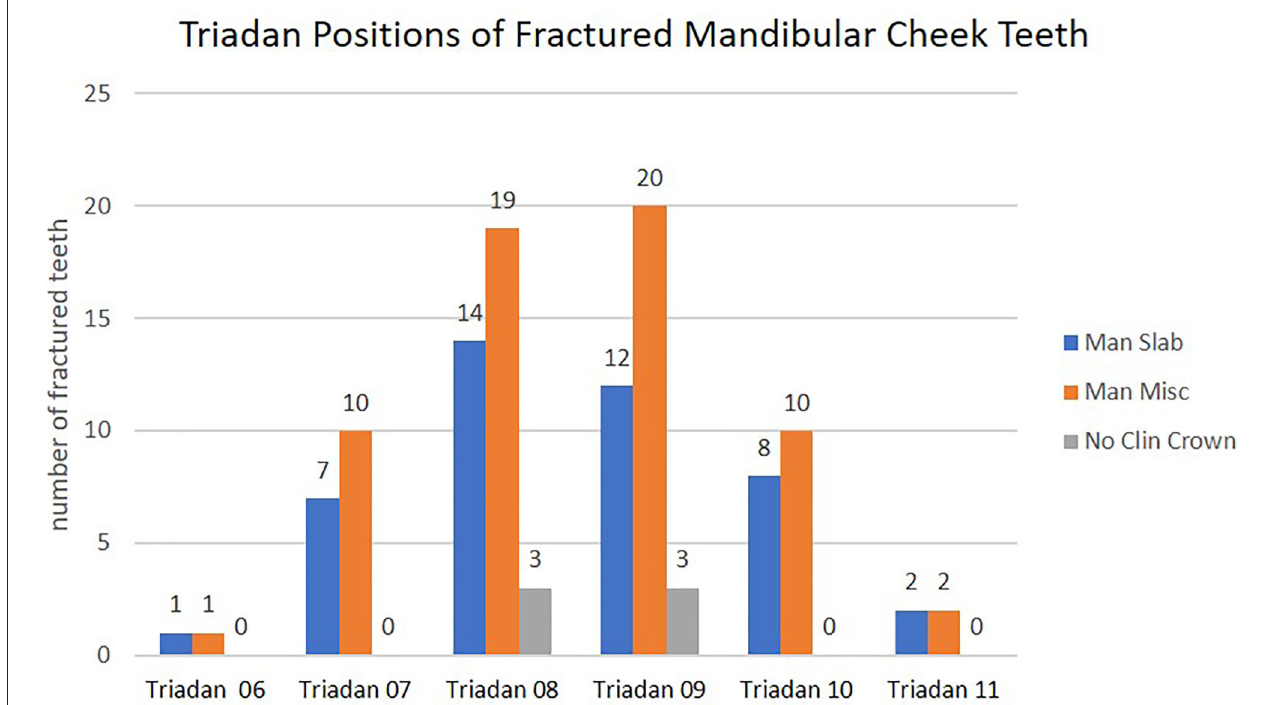
FIGURE 7 | Triadan positions of 112 fractured mandibular cheek teeth with three different fracture patterns according to Triadan positions. Man Slab, mandibular first and second pulp horn fractures; Man Misc, atypical mandibular cheek teeth fracture patterns; No Clin Crown, fracture with the absence of clinical